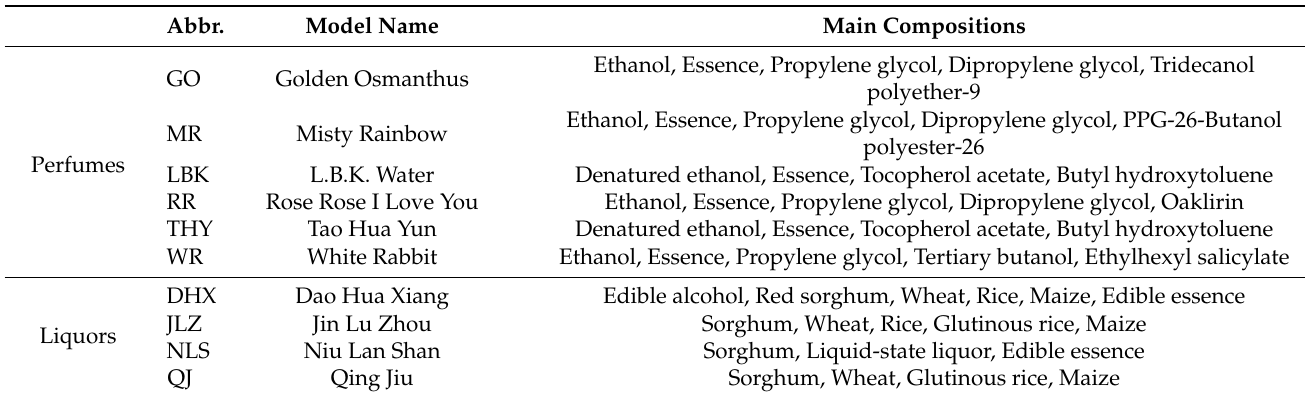
Table 1. Ranges of main tunable hyper-parameters of the tested